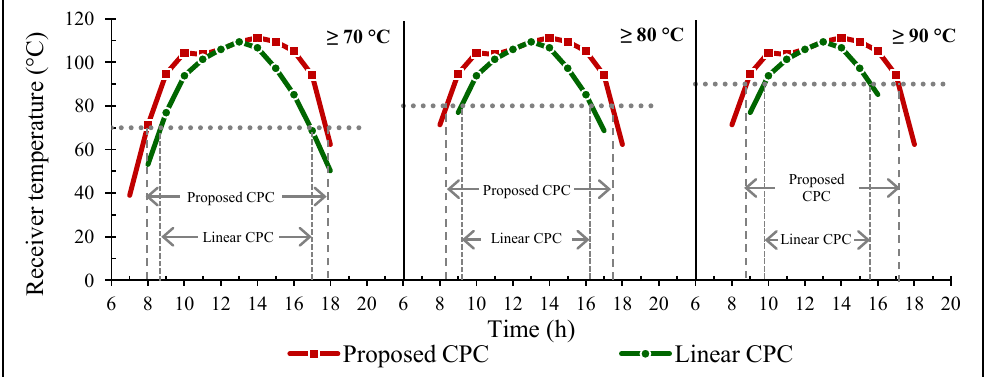
Figure 9. Duration of the selected temperatures per unit length of the proposed angled CPC and linear south-facing CPC (28 August 2005).